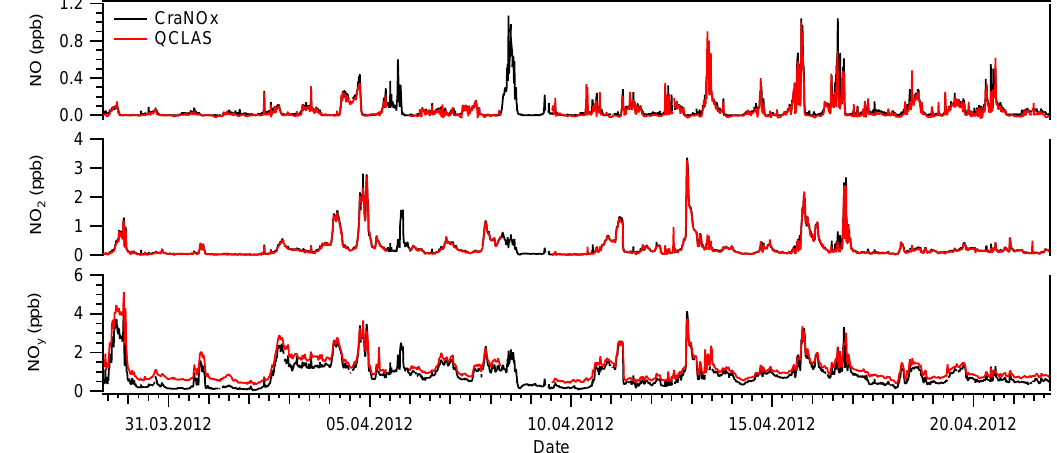
Fig. 5. An exemplary sequence of NO, NO 2 and NO y time series measured at the Jungfraujoch with the two different methods. Note the different scaling of the y-axis. The gaps in the QCLAS data were caused by additional on-site works, such as calibration and converter investigation (see details in text).